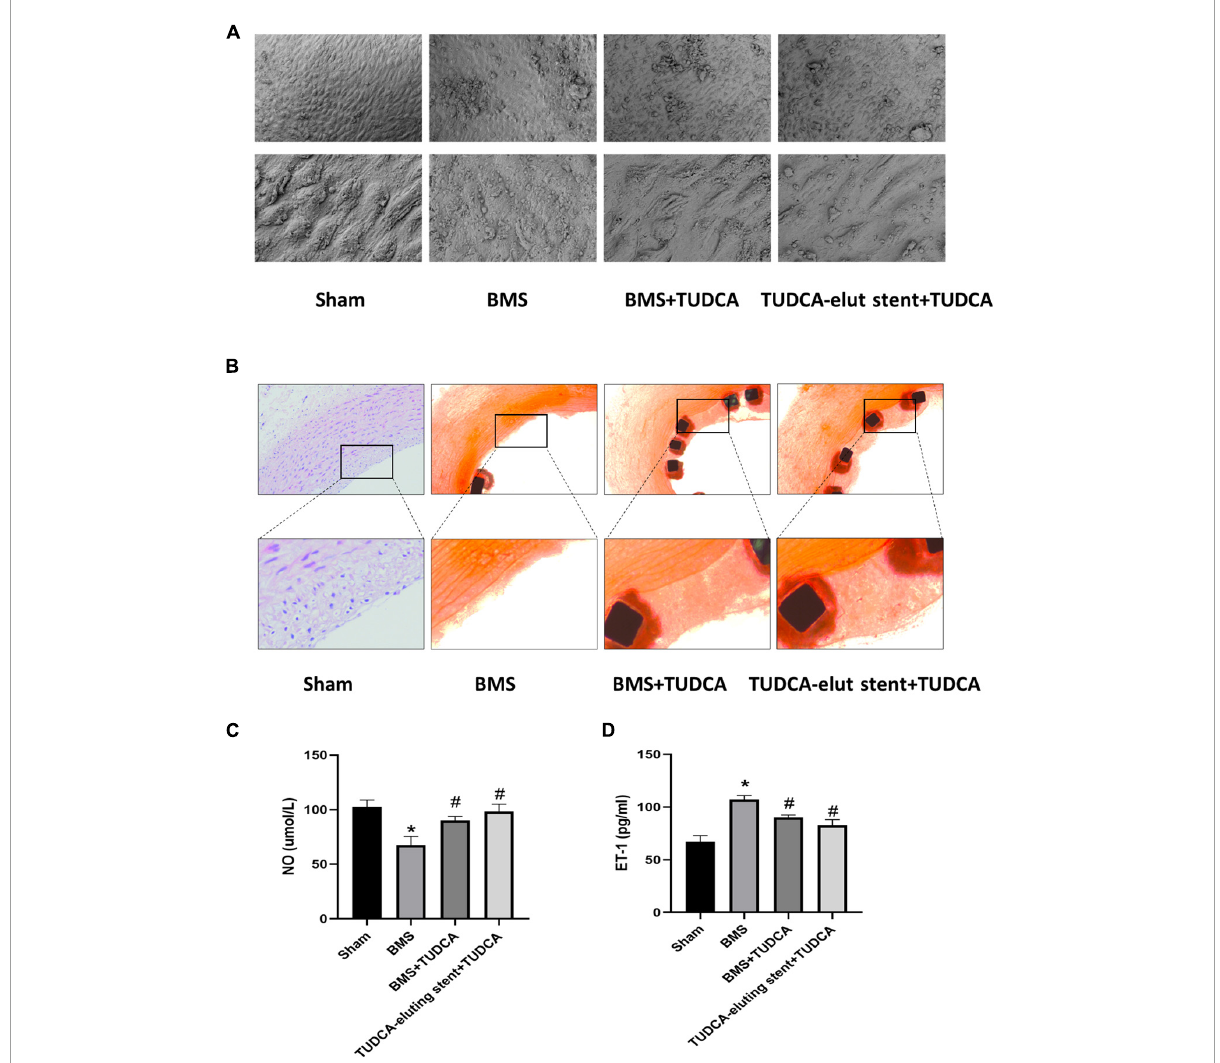
FIGURE2 Tauroursodeoxycholic acid (TUDCA) promotes re-endothelialization and inhibits restenosis after stent implantation in vivo . (A) The vascular surfaces of four groups (Shame, BMS, BMS+TUDCA, TUDCA eluting stent+TUDCA) were covered with endothelial cells. (B) Representative histological images of Shame, BMS, BMS+TUDCA, TUDCA eluting stent+TUDCA (HE staining). The framed part is the repaired intravascular surface. (C,D) The contents of ET-1 and NO in serum. (*Compared with Sham, #compared with